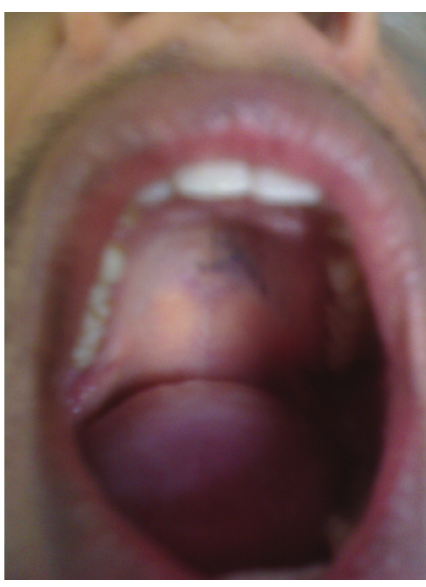
Figure 2: Intraoral involvement of nevus of Ota involving hard